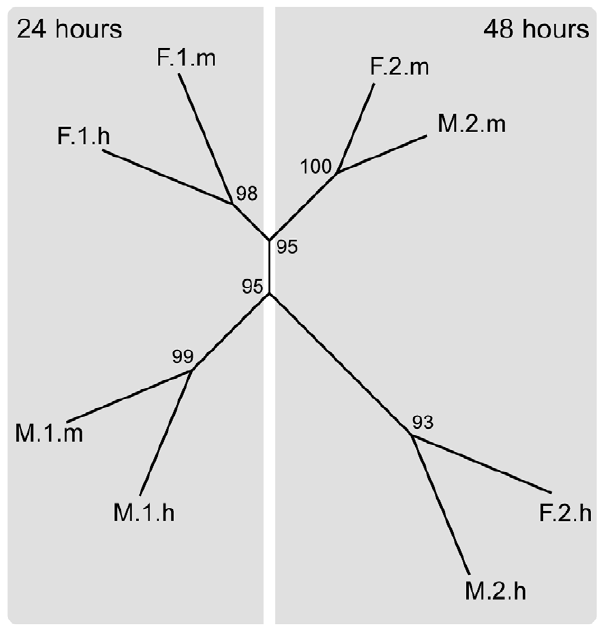
Figure 3. Radial tree of hierarchically clustered gene expres- sion profiles for M.faveolata embryos collected from Florida and Mexico after 24 and 48 hours of development. All three factors of time, location, and temperature played a role in shaping gene expression profiles. Note that clustering of day one samples was according to location (M and F), while clustering of day two samples was according to temperature treatment (m and h). Values along branches indicate approximately unbiased p-values of Suzuki and Shimodaira [55] based on 1000 bootstrap replicates. Abbreviations: M - Mexico; F - Florida, 1 - 24 hours; 2 - 48 hours; m - mean temperature; h - high temperature.